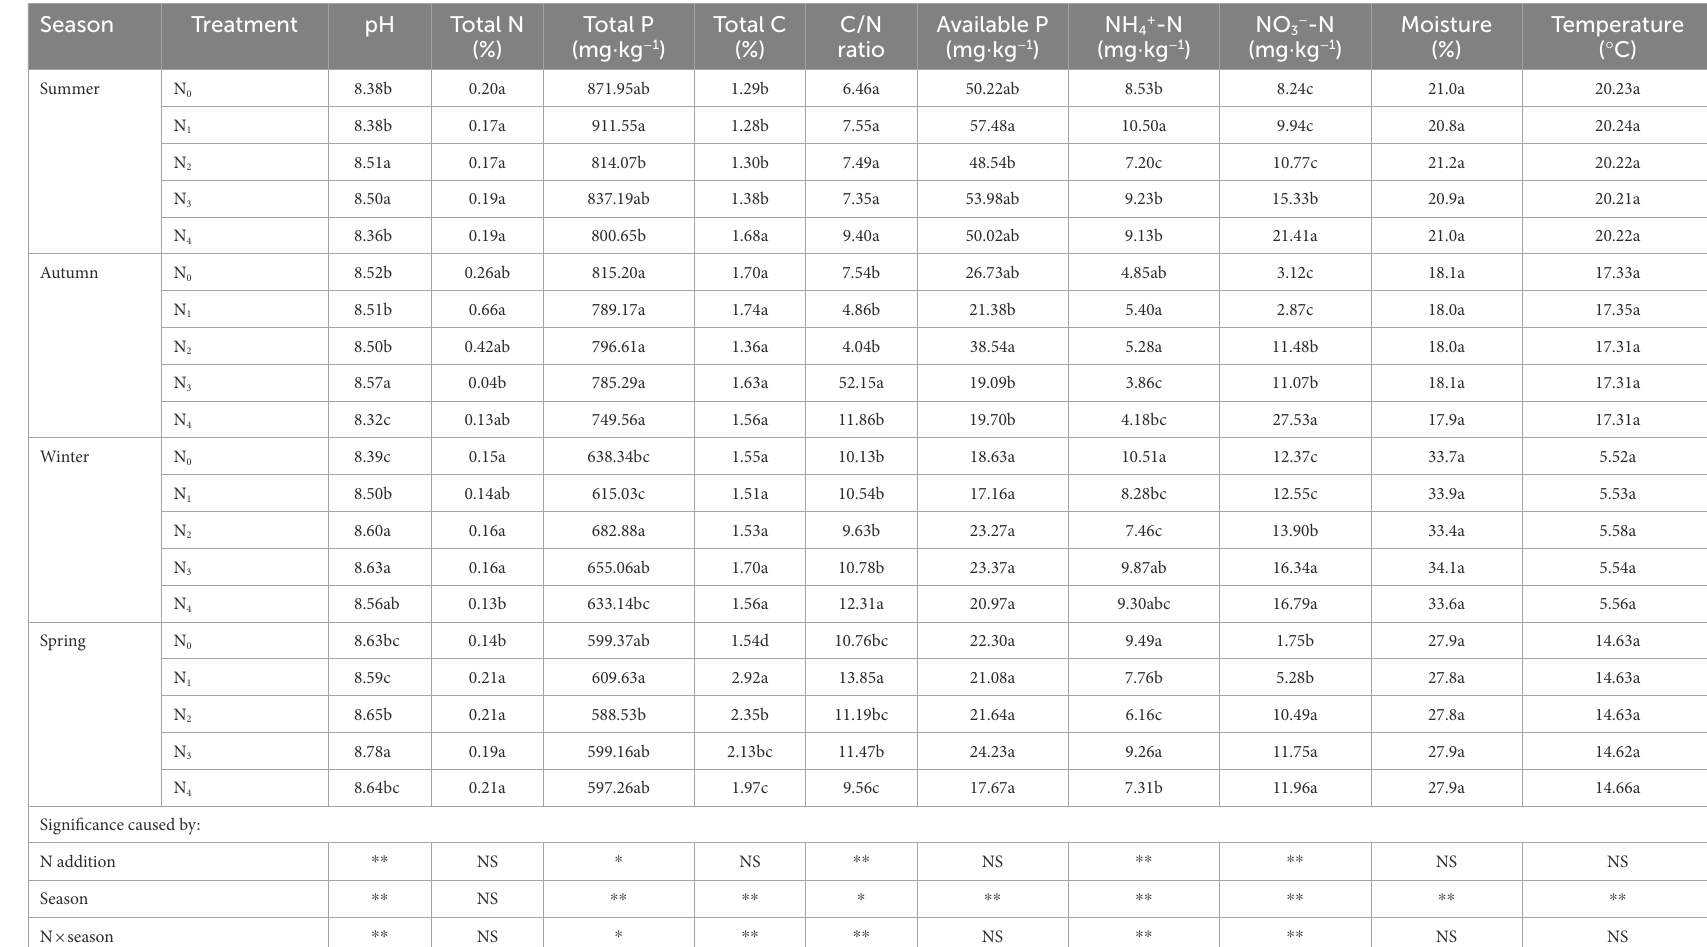
TABLE 2 Seasonal changes in soil physicochemical properties in the poplar plantations with different nitrogen additions.